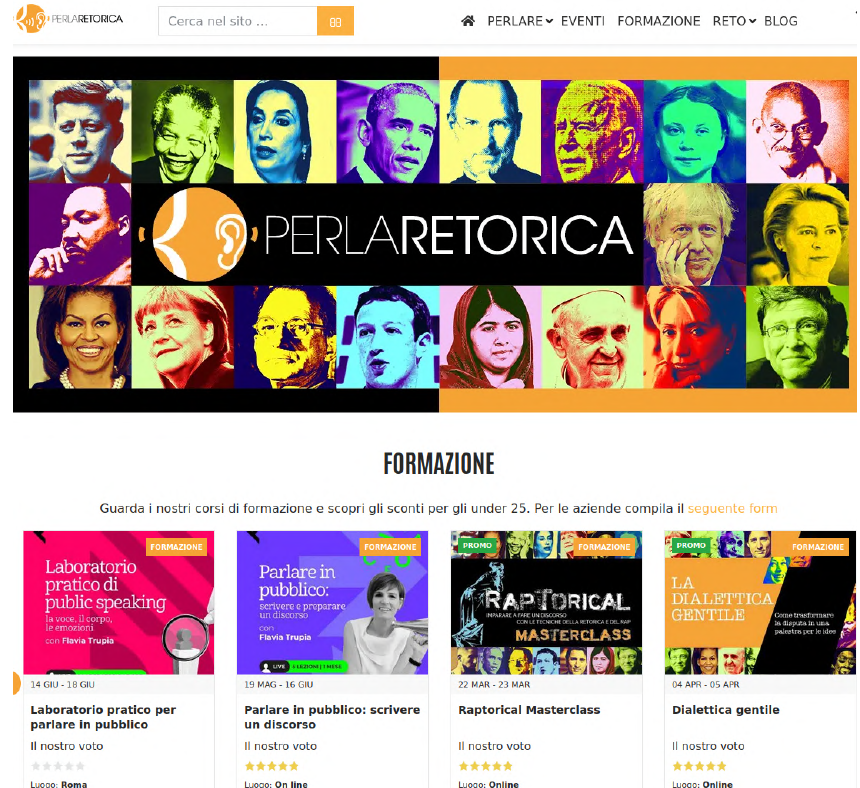
Figure 4: Resource of the Italian rhetorical association – Associazione Per La Retorica.